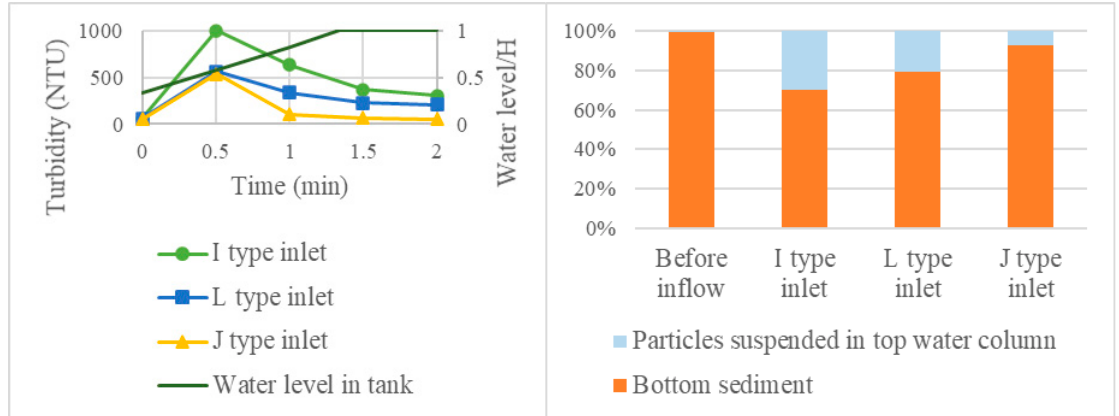
Figure 3. Turbidity variations and distribution of kaolin mass according to inlet type.